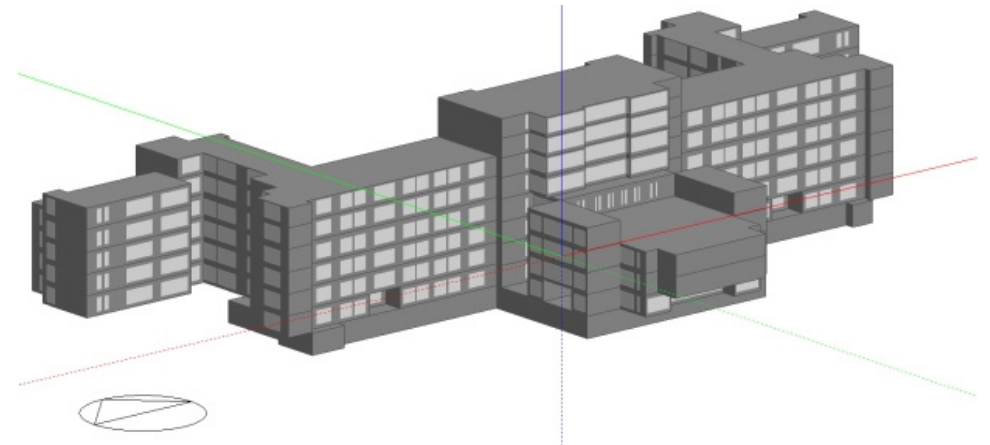
Figure 2. 3D model of sample building created in DesignBuilder.